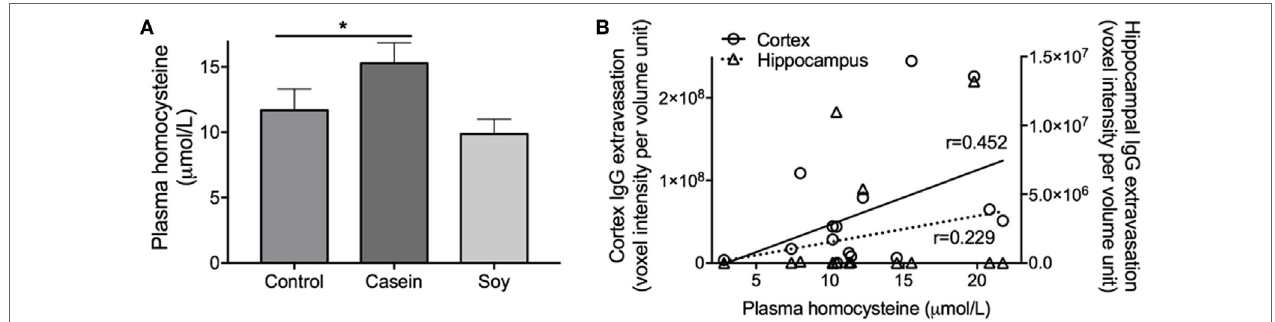
FigUre 3 | Plasma concentration of homocysteine. (a) Plasma homocysteine concentration was determined in mice maintained on control chow, high-casein diet, or high-soy protein diet using an immunoabsorbent assay. The statistical significance is indicated with * at p < 0.05 (one-way ANOVA with Fisher’s LSD post hoc test, n = 10). Data shown as mean ± SEM. (B) The associations between plasma homocysteine levels and cerebral parenchymal immunoglobulin g (IgG) extravasation were determined by Pearson’s correlation coefficient